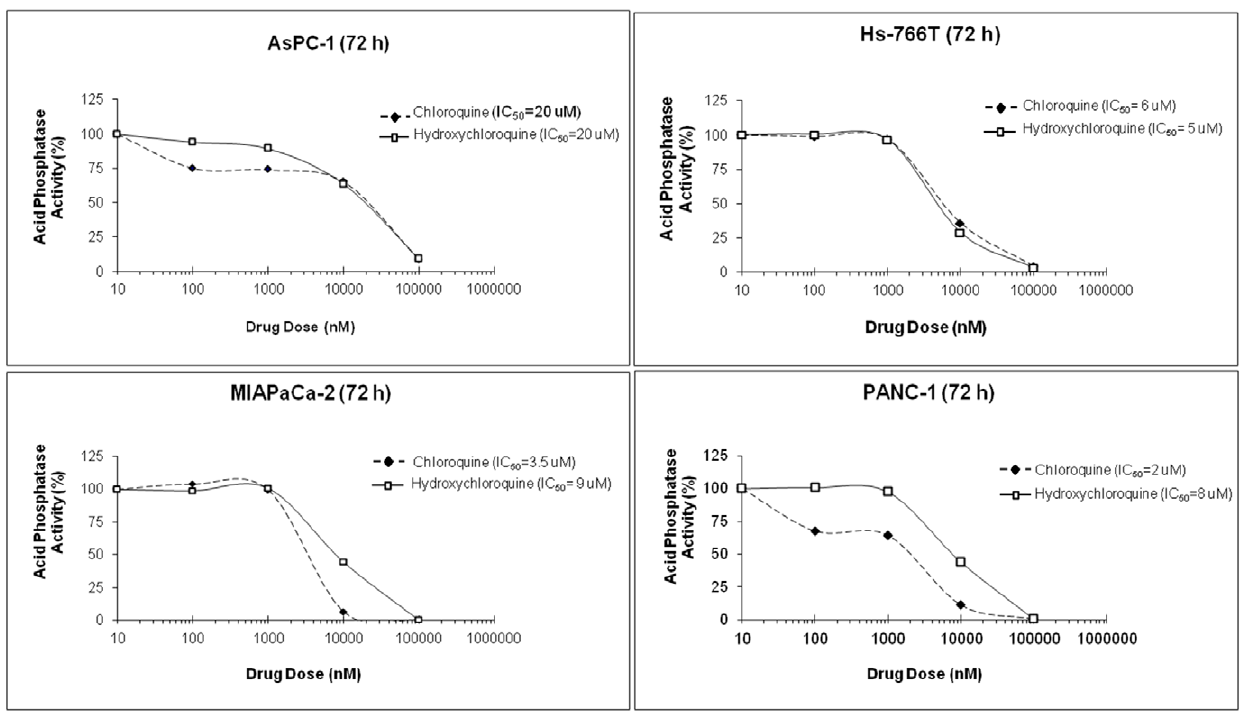
Figure 6. Kill curves for chloroquine and hydroxychloroquine treatment of pancreatic cancer cells. AsPC-1, Hs-766T, MIAPaCa-2, and PANC-1 cells were treated with a dose range of chloroquine or hydroxychloroquine (0.01–10 m M) at 72 hours to determine the half maximal inhibitory concentration (IC50 values) of these compounds. AsPC-1 and Hs-766T cells had similar IC50 values for chloroquine and hydroxychloroquine, whereas MIAPaCa-2 and PANC-1 cells had higher IC50 values for hydroxychloroquine than chloroquine.